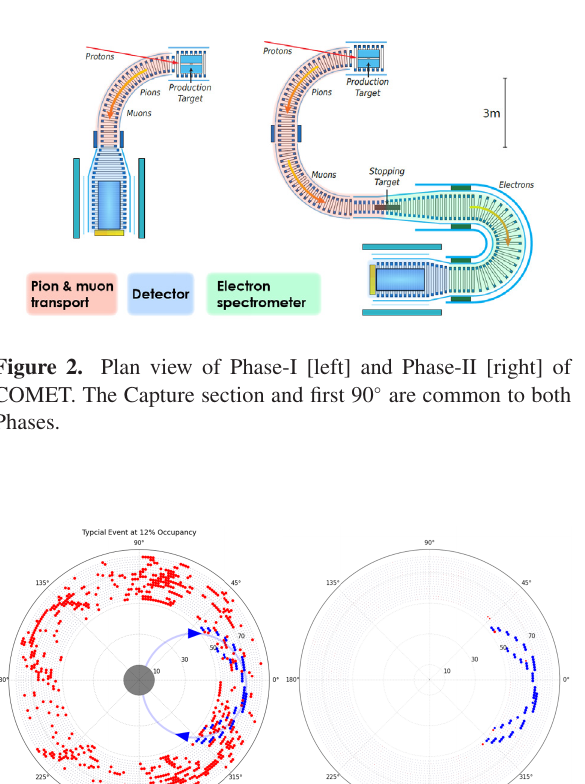
Figure 3. Reconstruction of simulated tracks. In the first step [left] hits are classified as signal-like (blue) or background-like (red). In the second step [right], a Hough transform based on the signal-like hits is used to select hits belonging to a track, which can be reconstructed in 3D using the two stereo